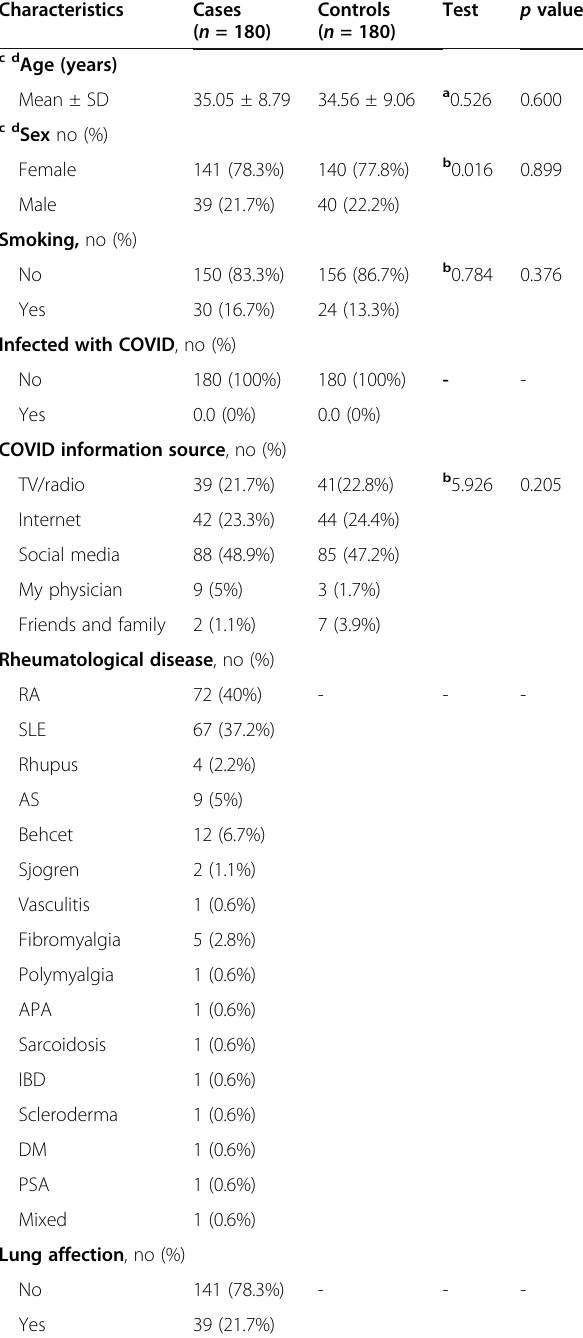
Table 1 Socio demographic and personal characteristics of the studied groups ( n = 360)